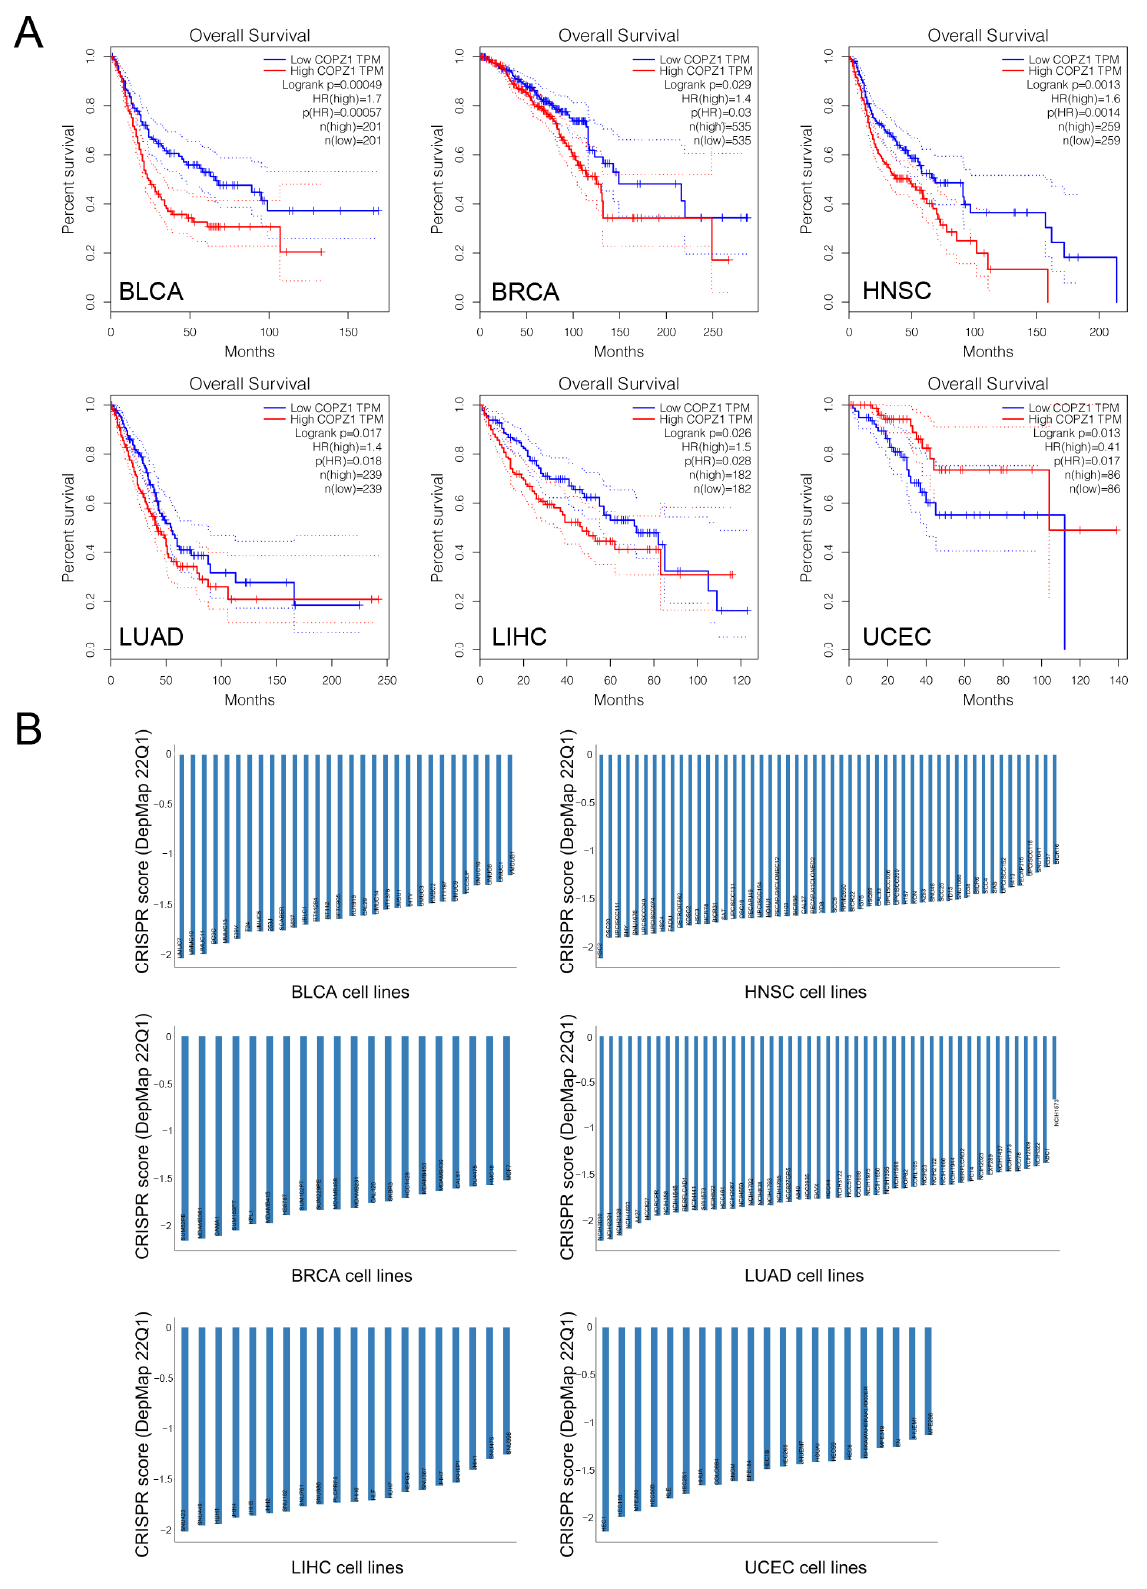
Figure 2. High expression of COPZ1 correlated with poor prognosis. ( A ) Overall survival analysis of COPZ1 in BCLA, BRCA, HNSC, LIHC, LUAD, and UCEC in the TCGA dataset using GEPIA2. ( B ) The Achilles crisper score analysis of the sensitivity of cell lines to COPZ1 knockdown. The score below “0” indicated the cell growth inhibition by COPZ1